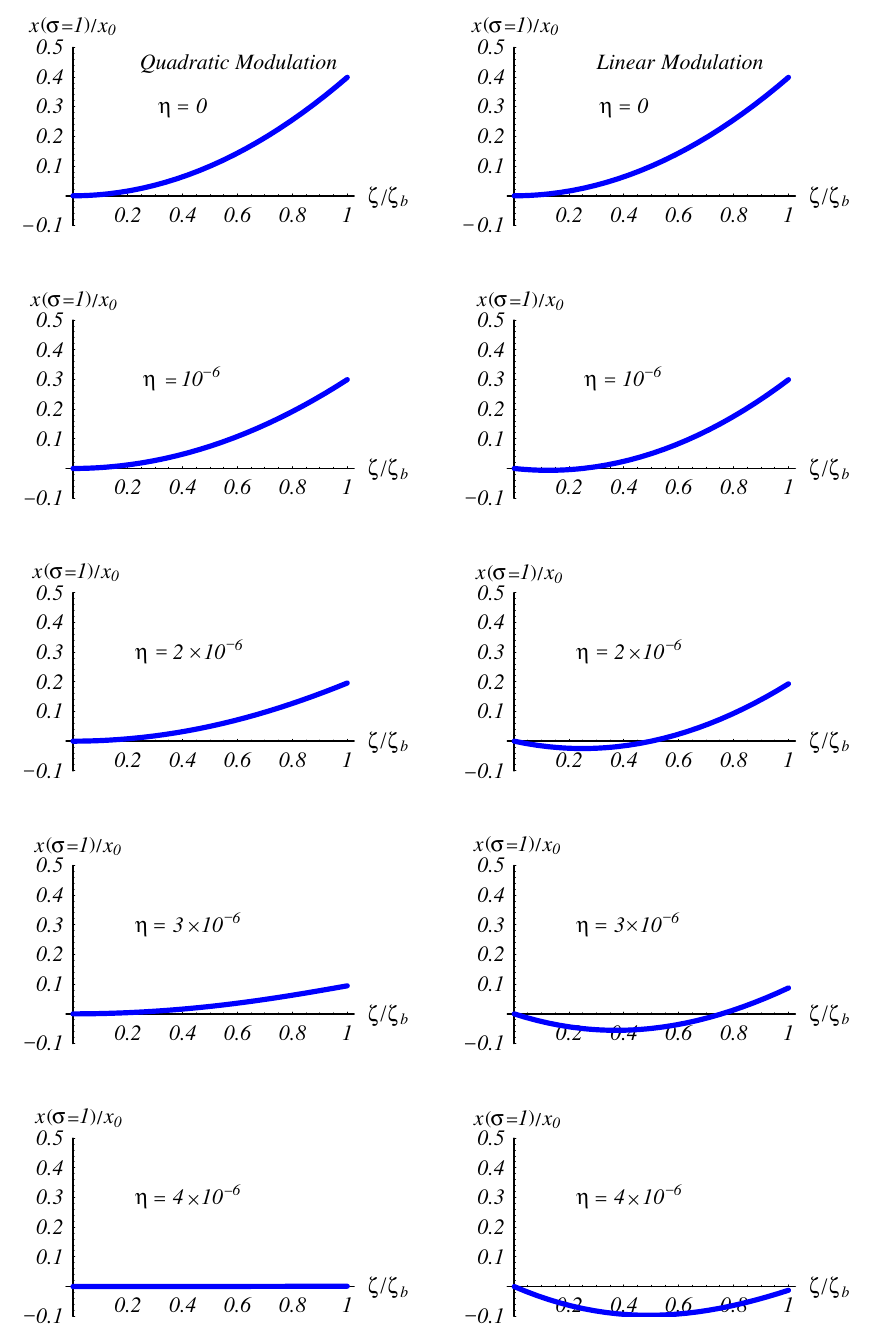
FIG. 1. (Color) Bunch shape at the exit of the accelerator as a function of focusing modulation for a quadratic (left) or linear (right) time dependence of the modulation. The parameter # is the amount of focusing modulation defined by Eqs. (27) and (29). See text for the other accelerator for quadratic (left) and linear (right) time de- pendence of the focusing modulation. The parameter # represents the rate of modulation of the focusing as defined by Eqs. (27) and (29). The focusing strength is set at (cid:6) 100 : 5 (cid:28) ; this implies that, since (cid:2) (cid:7) 1 , the lateral displace- ment is due entirely to the coupling with the deflecting mode and to the focusing modulation, and not to the